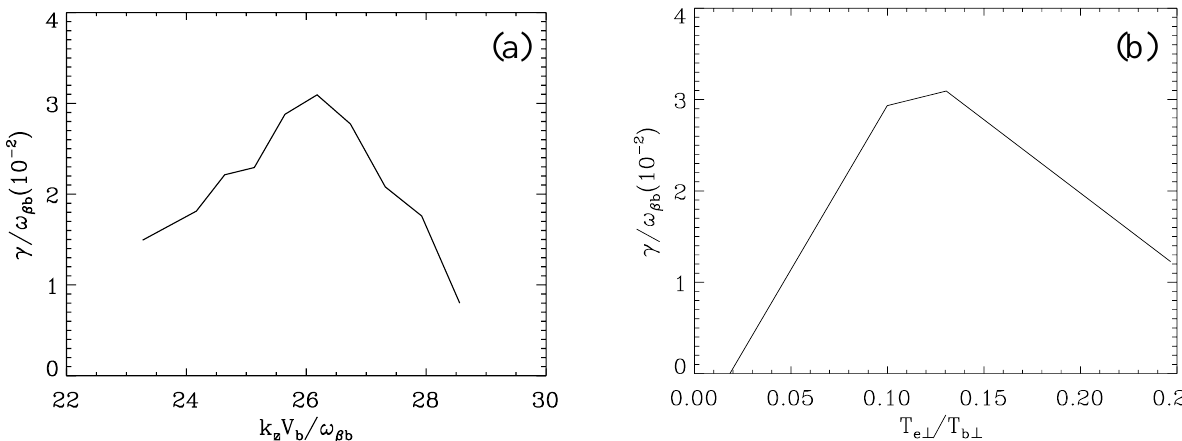
FIG. 4. Plots of the linear growth rate g (cid:1) Im v , including (a) g (cid:1) v b b versus k z V b (cid:1) v b b and (b) g (cid:1) v b b versus T e (cid:1) (cid:1) T b (cid:1) .